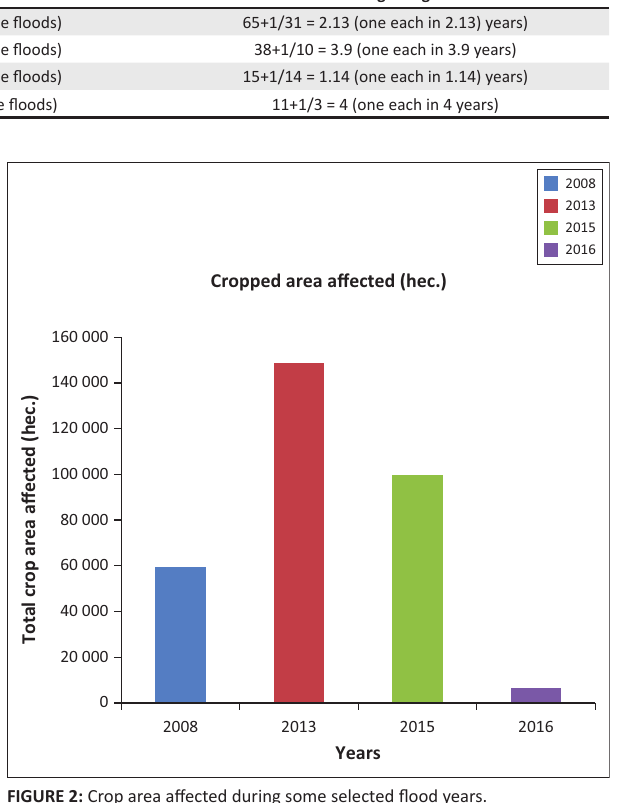
FIGURE 2: Crop area affected during some selected flood years.